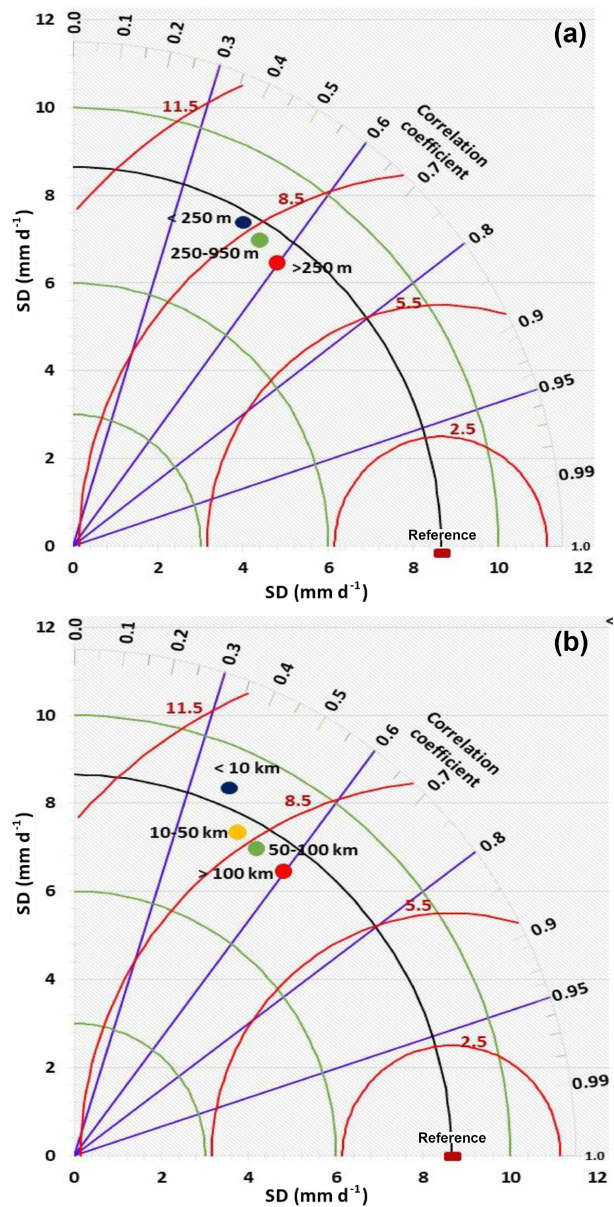
Figure 3. (a) Elevation zones. (b) Distance zones. Time series of rain-gauge (reference) vs. CMORPH estimations, period 1999– 2013, for elevation zones (a) and distance zones (b) in the Zam- bezi basin. The correlation coefficients for the radial line denote the relationship between CMORPH and gauge-based observations. Standard deviations on both the x and y axes show the amount of variance between the two time series. The standard deviation of the CMORPH pattern is proportional to the radial distance from the origin. The angle between symbol and abscissa measures the cor- relation between CMORPH and rain-gauge observations. The root mean square difference (red contours) between the CMORPH and rain-gauge patterns is proportional to the distance to the point on the x axis identified as “reference”. For details, see Taylor